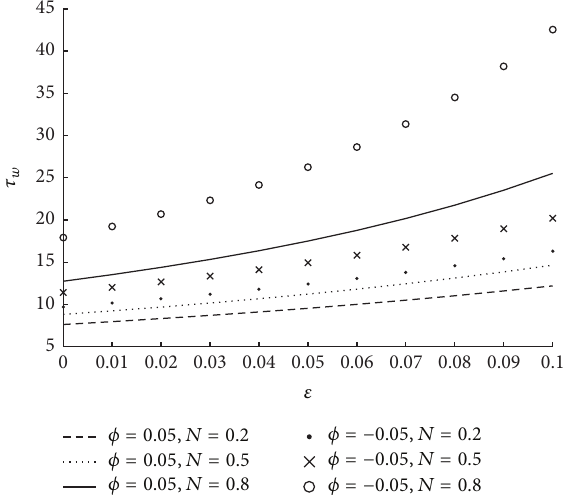
Figure 13: The variation of shear stress at wall in stenosed region with respect to 𝜙 , 𝜖 when 𝑁 = 0.75 , 𝑟 𝑐 = 0.1 , 𝑢 = 0.01 , and 𝑚 = 10